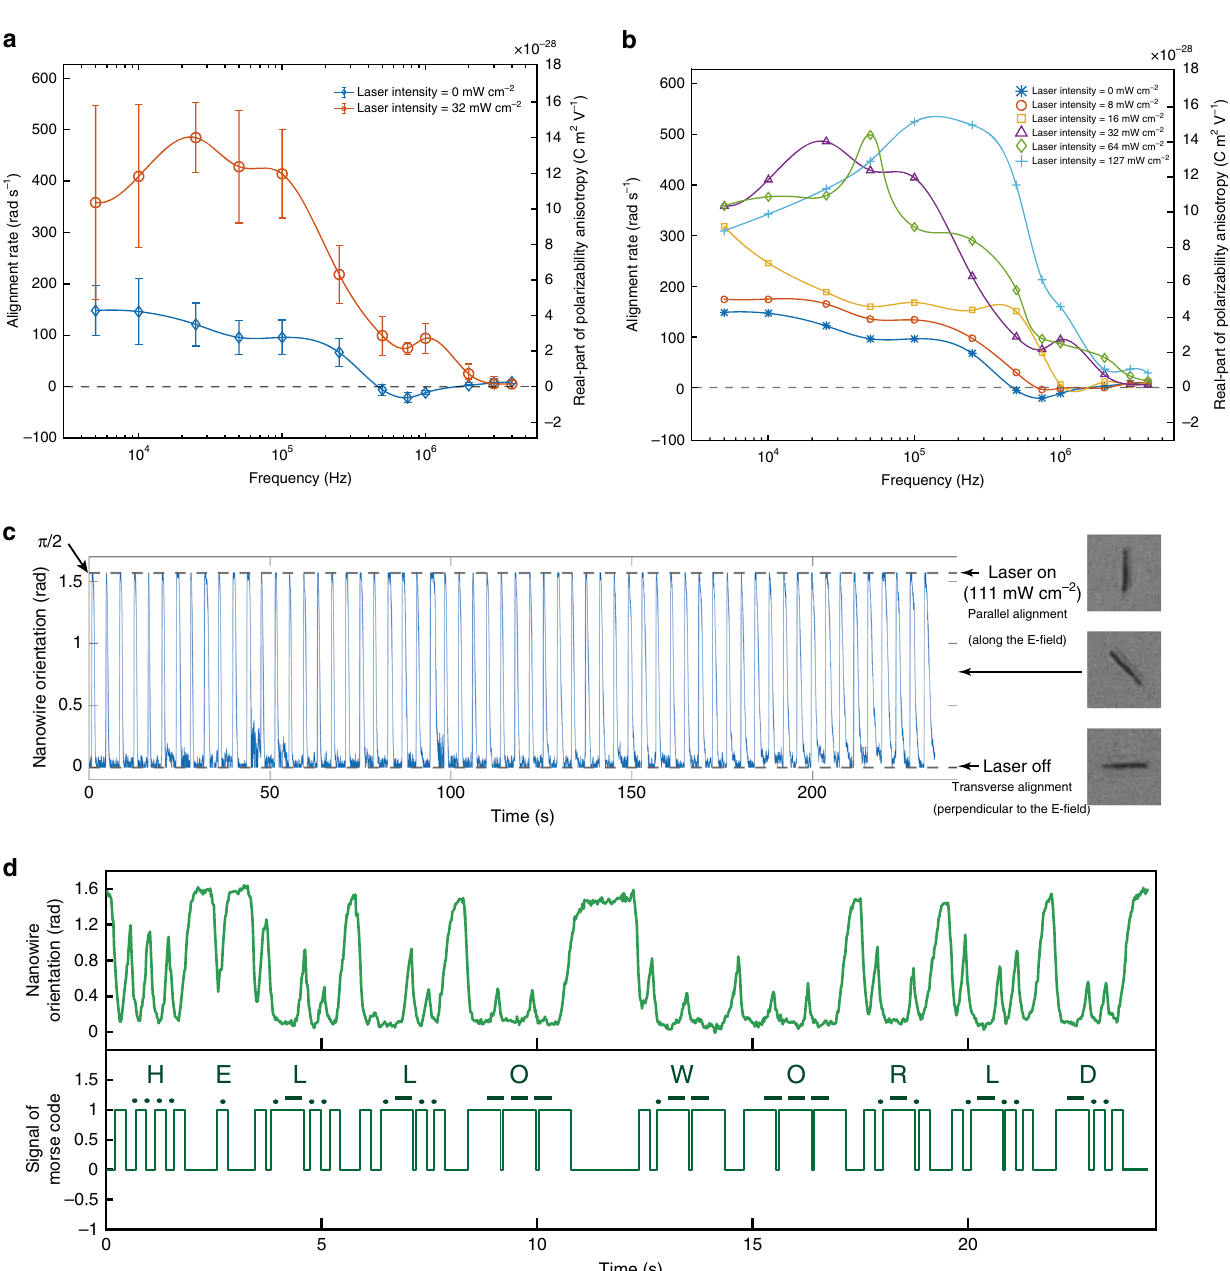
Fig. 2 Light-responsive alignment of Si nanowires. a Alignment rate versus AC frequency of silicon nanowires (undoped; length, 10 μ m; diameter, 500 nm) in the dim condition and under 532-nm laser illumination (error bars are de fi ned as s.d., source data are provided in a Source Data fi le). b Intensity effect of laser on alignment rate versus AC frequency. The corresponding anisotropy of polarizabilities are shown on the right axes, and the eye-guiding lines in ( a ) and ( b ) show trends. c Cyclic switch between parallel and transverse alignment of a single nanowire with on/off of a 532 nm laser. The E- fi eld direction is de fi ned as π /2, and its transverse direction is de fi ned as 0. d Toggling of a single nanowire in response to a light signal encoded by Morse code (top), and the corresponding interpreted words “ HELLO WORLD ” from the mechanical motions of the nanowire